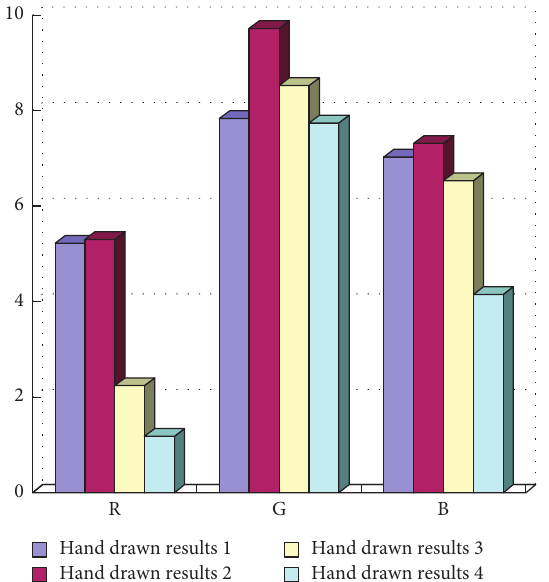
Figure 10: Comparison between color fusion